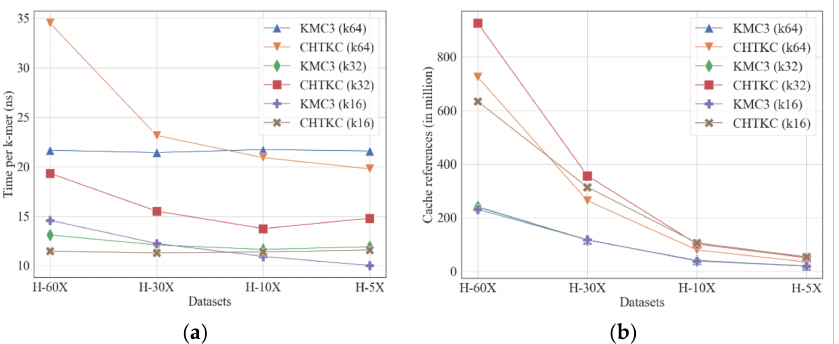
Figure 5. Comparison of KMC3 and CHTKC with various sequencing depth. ( a ) running time; ( b ) cache